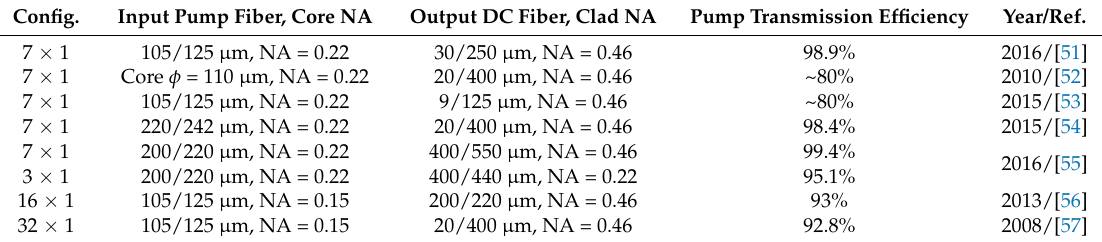
Table 1. Summary of recently reported pump power combiners